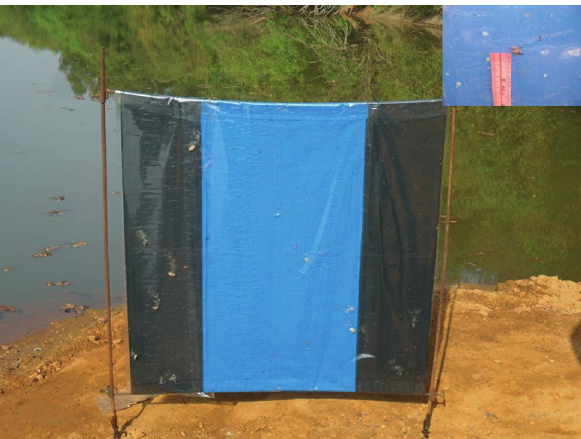
Figure 1. – Écran noir/bleu/noir recouvert avec le film adhésif sur la berge du fleuve Comoé. En haut à droite figure un exemple de mesure de la hauteur des glossines